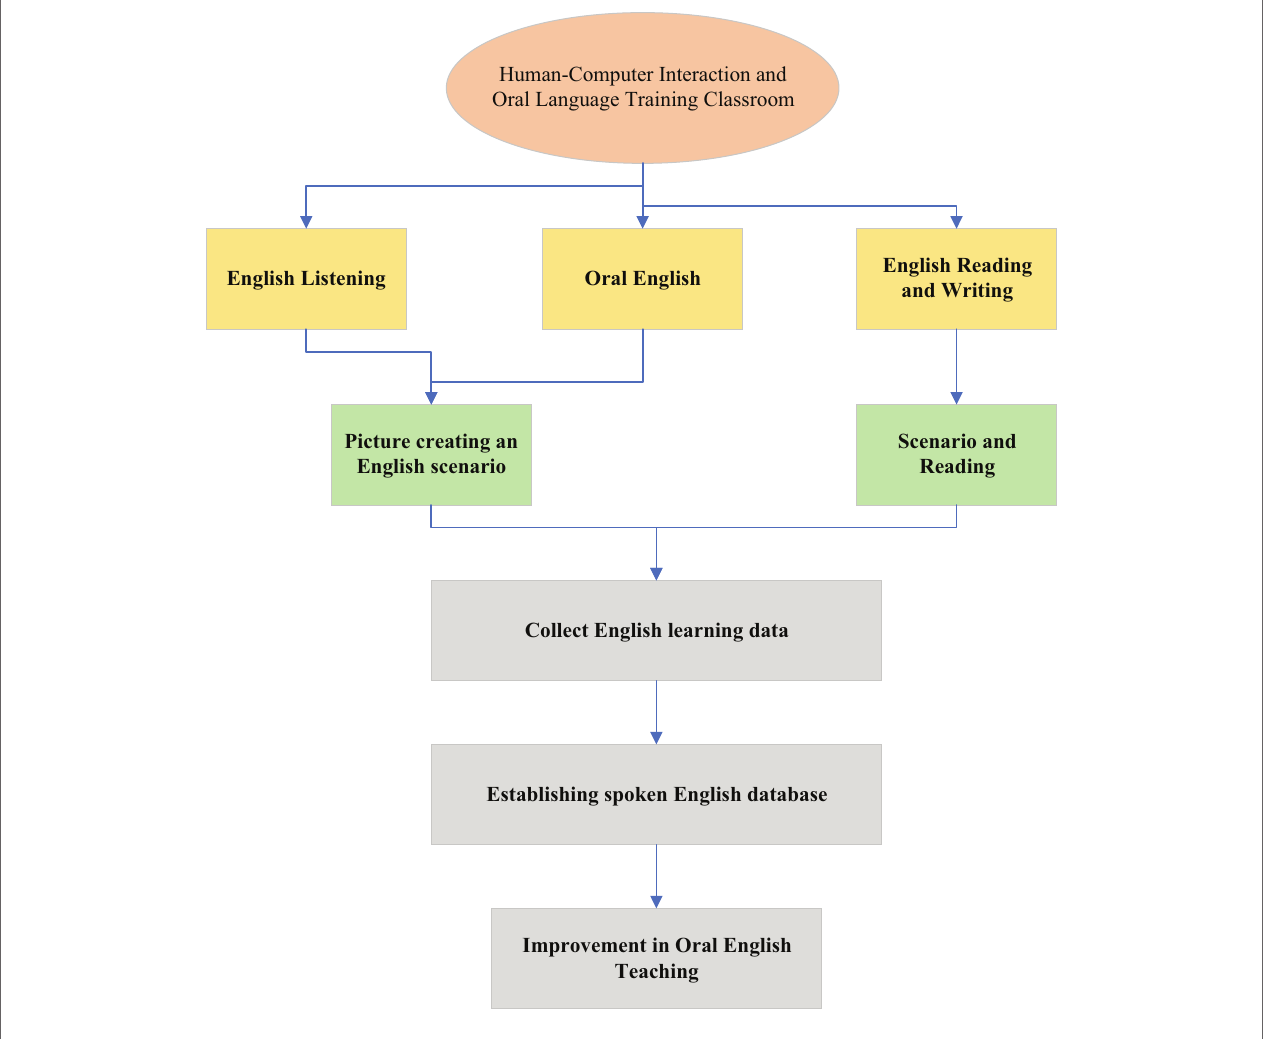
FIGURE 5 | Flow chart of HCI oral training